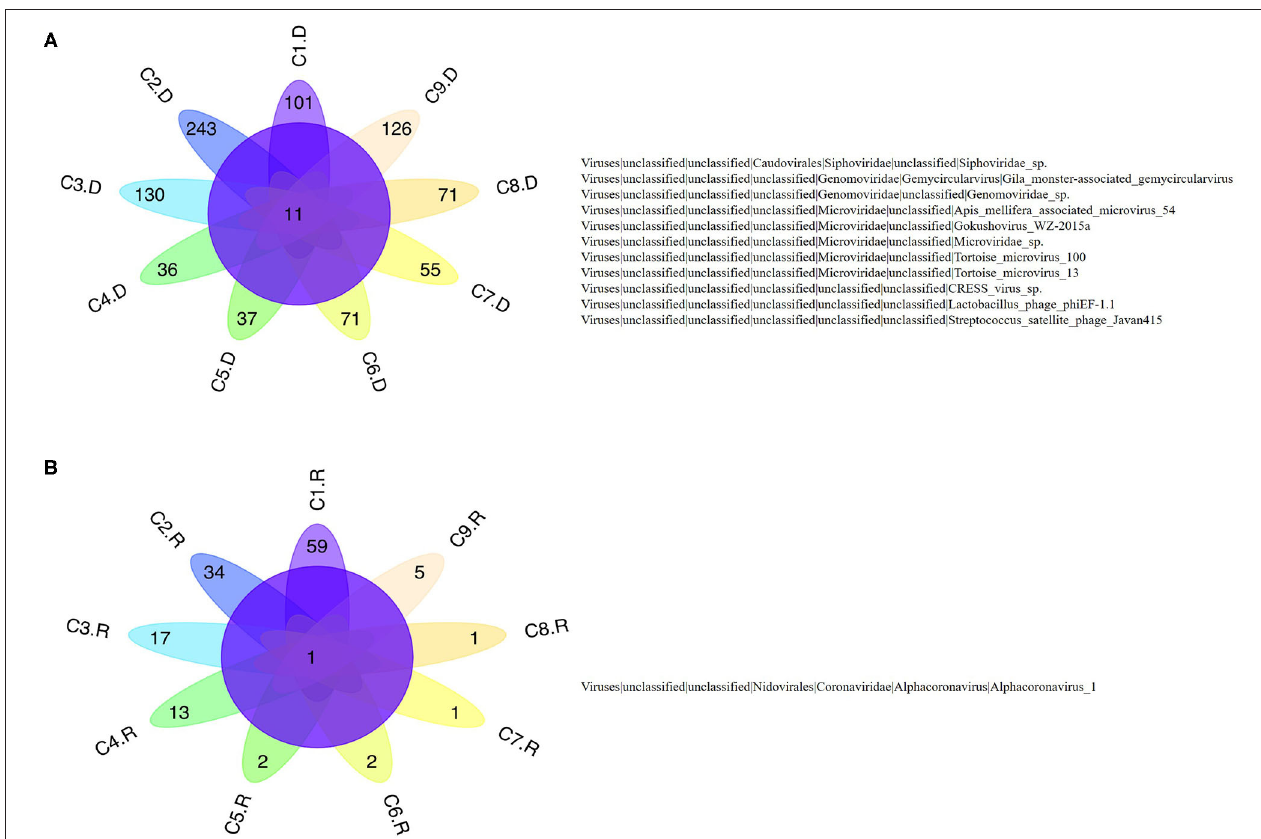
FIGURE 4 | The shared virus distributions of the nine databases. (A) The shared virus distributions of DNA virome. (B) The shared virus distributions of RNA virome.